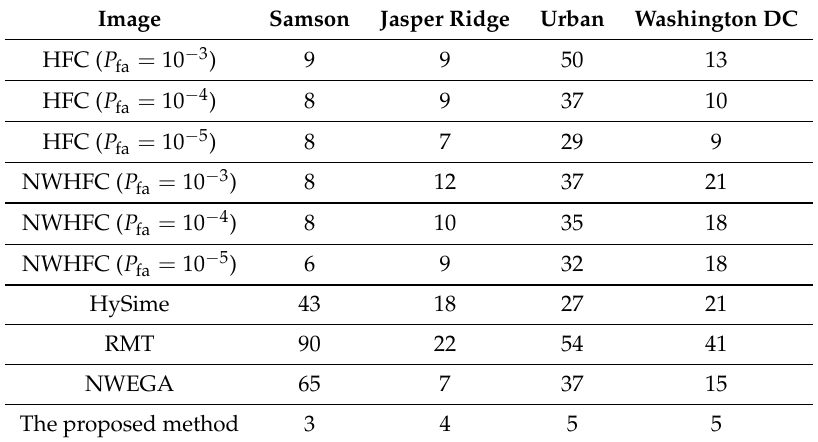
Table 3. Estimated number of endmembers in each test image using HFC, NWHFC, HySime, RMT, NWEGA, and the proposed